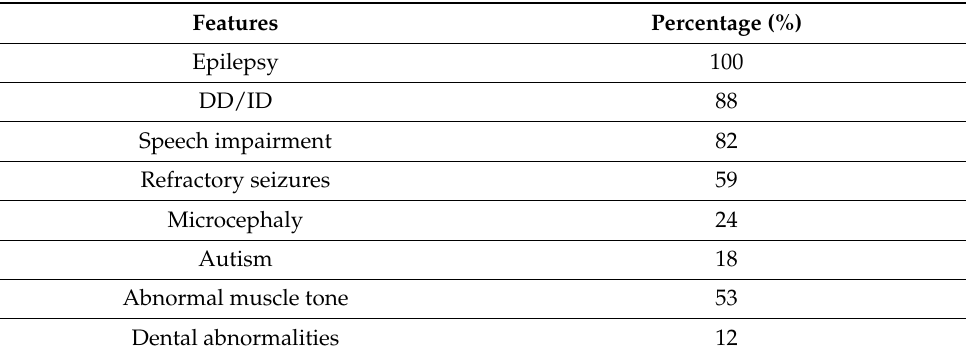
Table 2. Main clinical features of patients having